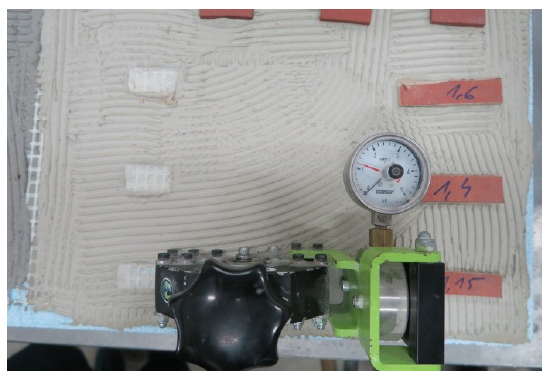
Figure 4: PressoMess for shear strength testing